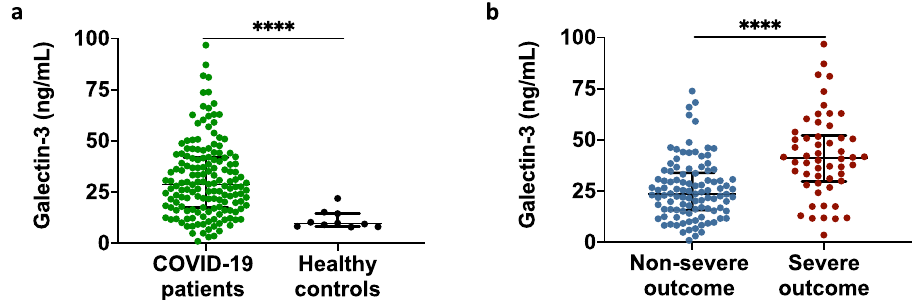
Figure 1. Galectin-3 serum levels in COVID-19 patients. ( a ) Galectin-3 circulating levels upon hospital admission of COVID-19 patients (n = 156) and age-matched healthy pre-pandemic controls (n = 10). ( b ) Severe outcomes in COVID-19 patients were associated with elevated levels of galectin-3. Data in ( a , b ) are shown as median with IQR. **** p < 0.0001; two-tailed Mann–Whitney U test or two-tailed t-test. Samples were assessed in duplicate in ELISA assays.